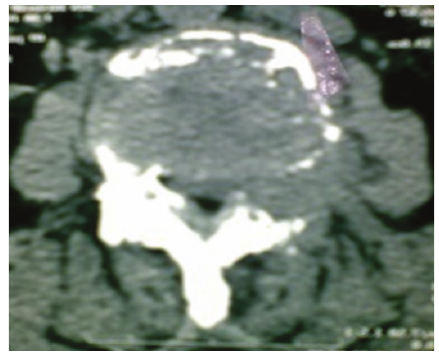
Figure 3: L3 compaction.